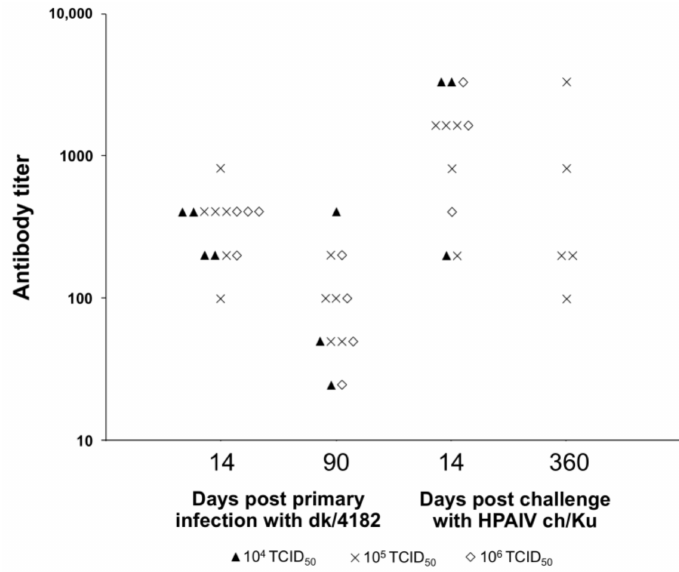
Figure 1. Titers of anti-H5 antibodies in sera of individual ducks (measured by ELISA) on days 14 and 90 after oral infection with 10 4 –10 6 50% tissue culture infective doses of dk/4182 and on days 14 and 360 after challenge with